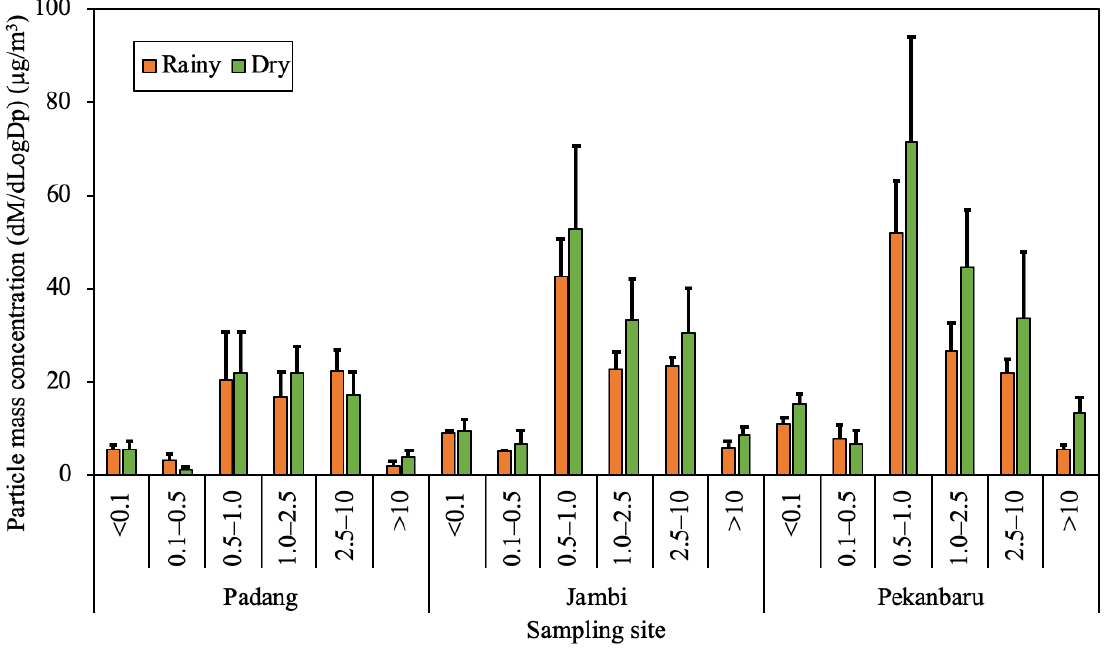
Figure 3. Particle size distribution observed at the study sites in Sumatra island.